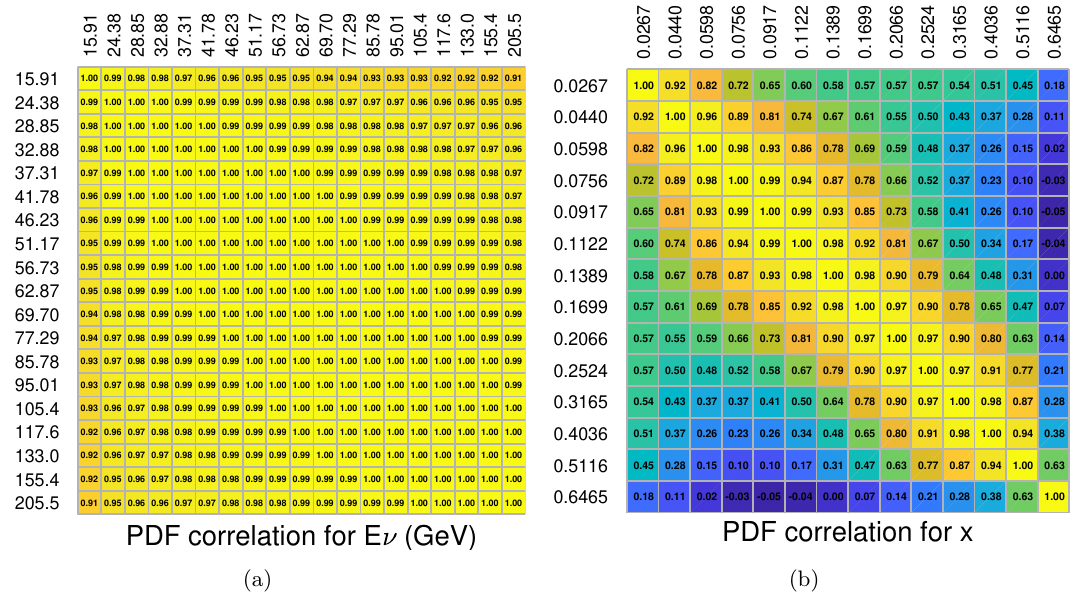
Figure 16 . PDF induced correlations between theory predictions for different experimental bins, for NOMAD distribution in neutrino energy (a) and in Bjorken- x (b), calculated with CT18 NNLO Hessian PDF set. Numbers in the axis represent the center of each bin, and numbers in the table represent the correlation cosine for each pair of